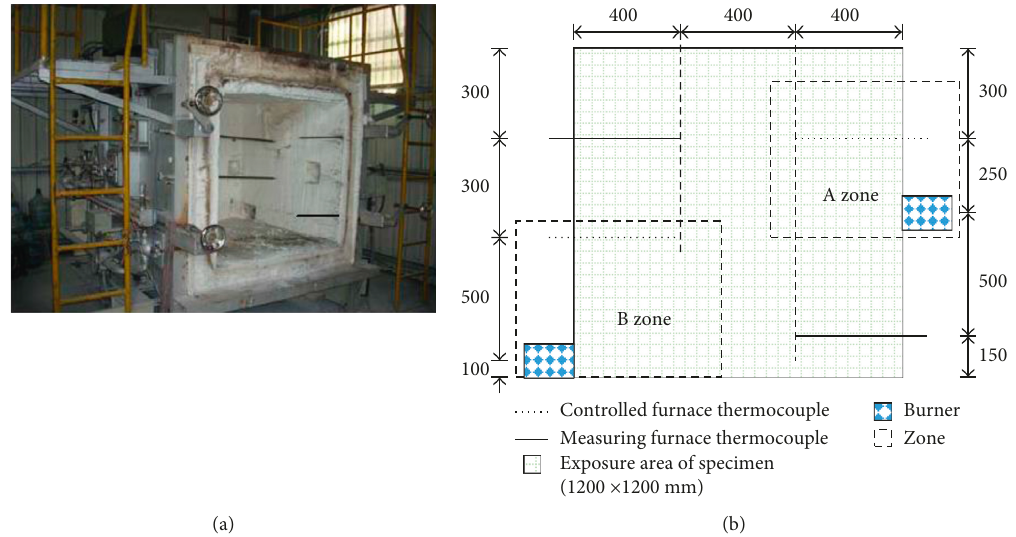
Figure 2: Small-size high-temperature furnace (inner size: 120cm in width, 120cm in height, and 120cm in